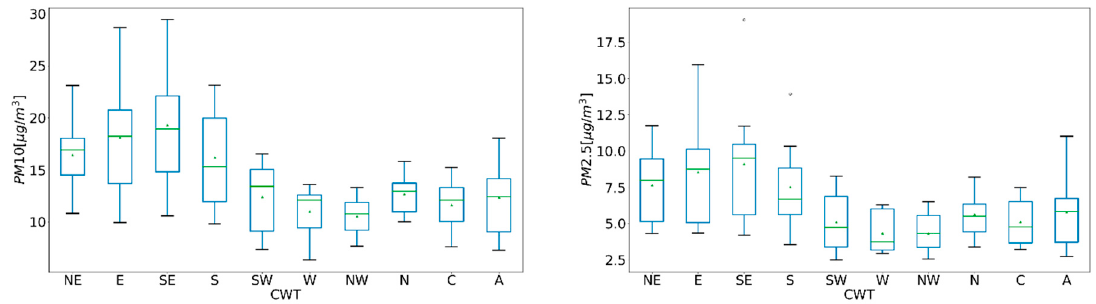
Figure 4. Box–Whiskers plots with the concentrations of PM10 and PM2.5 coherent with the results obtained through the CWT methodology for all the monitoring stations over the period 2006–2018. The box and whiskers present the median, the first and third quartiles, the minimum and maximum value and possible outliers. Small dots represent the